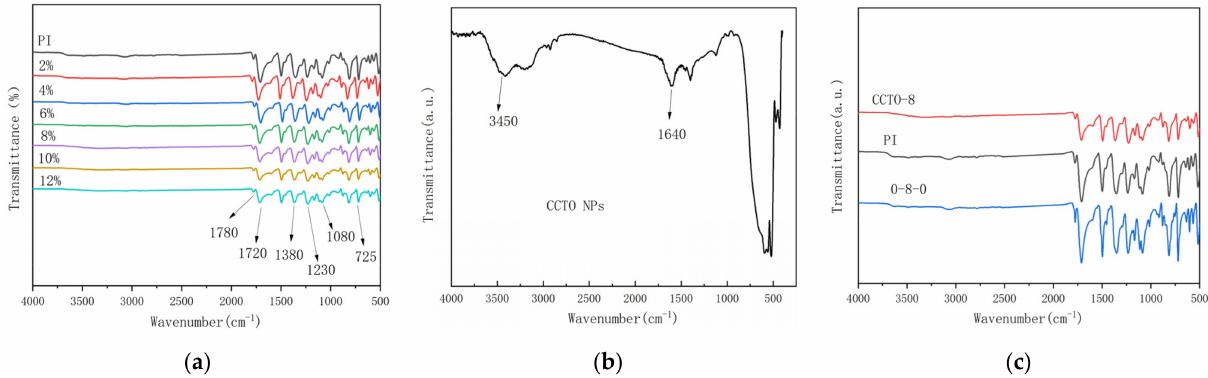
Figure 2. FT − IR spectra of nanocomposite films. ( a ) FT − IR spectra of pure PI film and different doping mass fractions of CCTO/PI films. ( b ) FT-IR spectra of CCTO NPs. ( c ) FT − IR spectra of CCTO/PI film, a pure PI film and a 0-8-0 sandwich